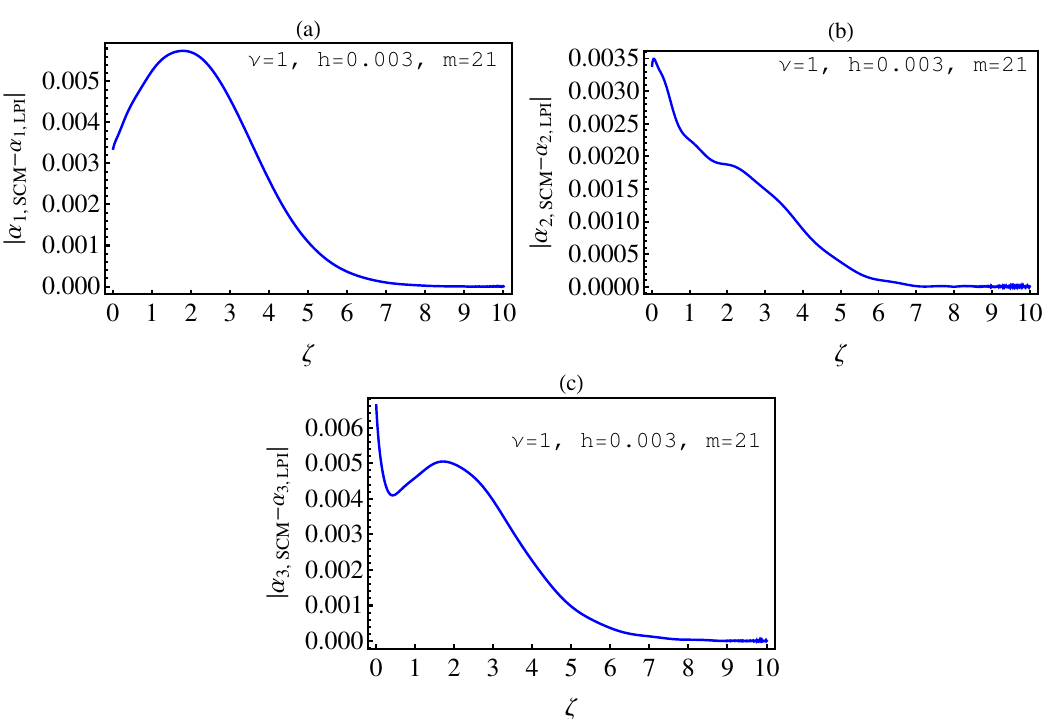
Figure 3. The absolute error between the numerical solutions of (2) to (4) based upon the LPI and the SCM for ν = 1, h = 0.03, m = 21, λ = 2, (cid:101) = 1, µ = 2, δ = 1 for the initial values α 1 ( 0 ) = 0, α 2 ( 0 ) = 1 and α 3 ( 0 ) = λ (( a ), ( b ) and ( c ),